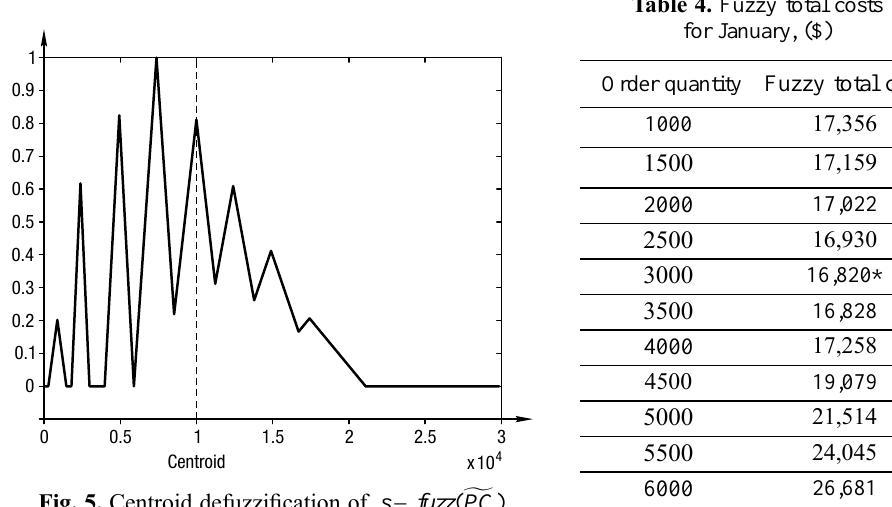
Fig. 5. Centroid defuzzification of